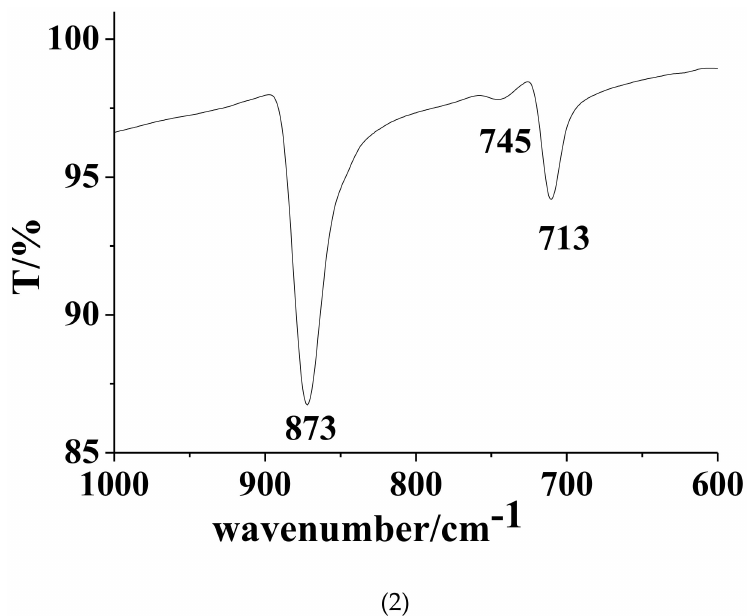
Figure 5. FTIR spectra of CaCO 3 crystals on the cathode surface in the blank scaling solution, under di ff erent polarization potentials. ( 1 ) Polarization at − 1.0 V; ( 2 ) Polarization at − 1.5 V.